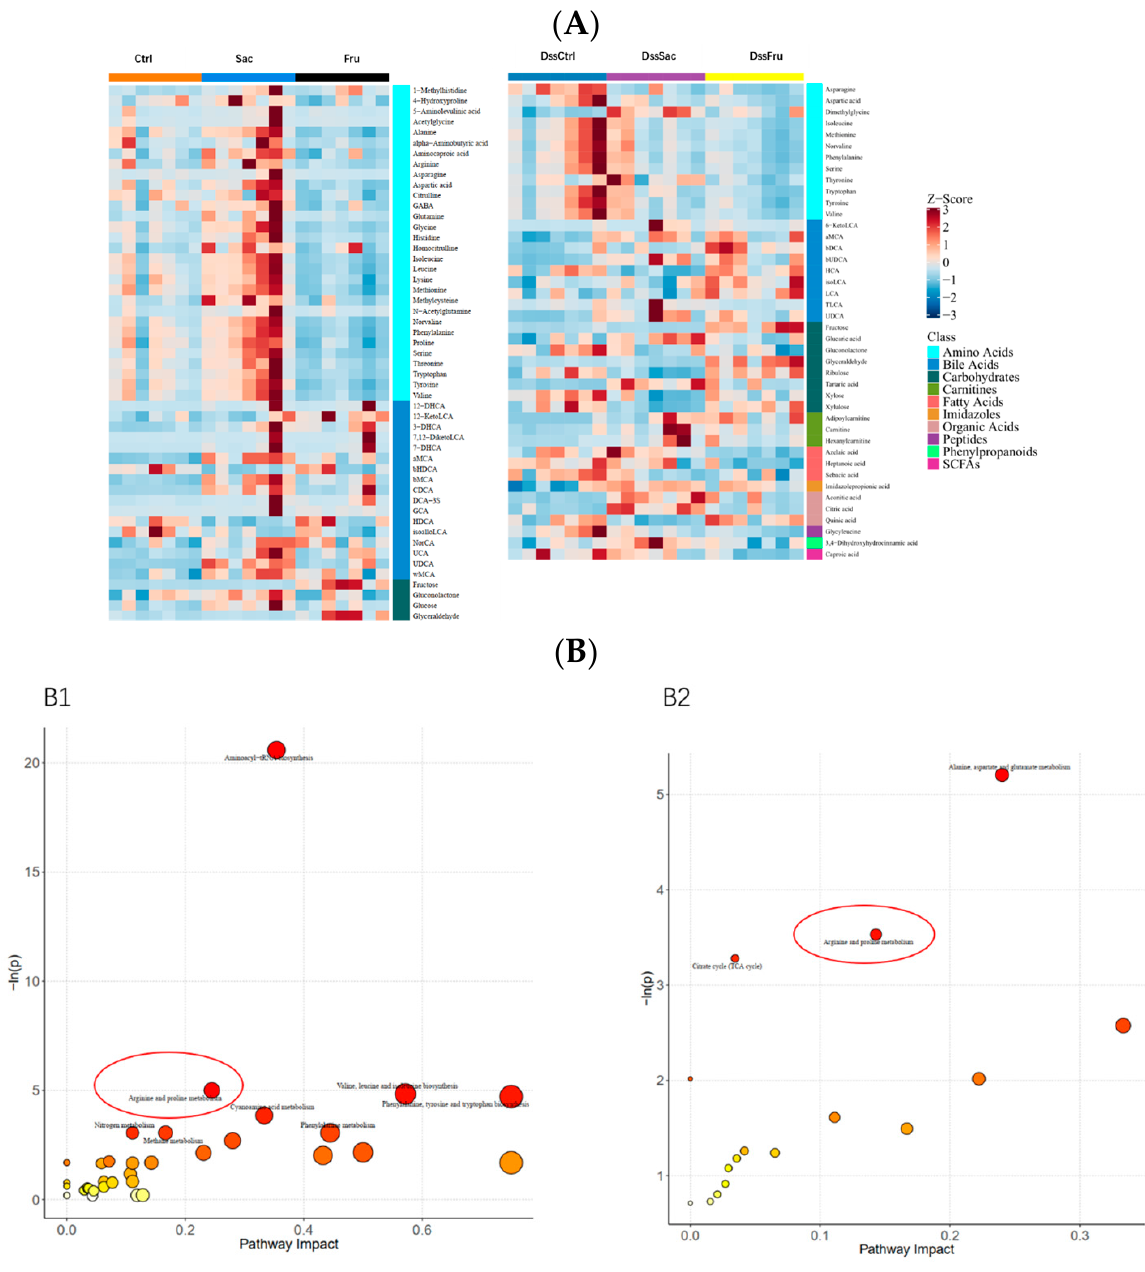
Figure 6. Sucrose and fructose alter colonic metabolite profiles. ( A ) Heatmap of sucrose and fructose’s alteration of metabolites; ( B ) KEGG annotation analysis of the altered metabolites based on the differences between sucrose and fructose; B1 KEGG annotation barplot of Sac vs. Fru; B2 KEGG annotation barplot of DssSac vs. DssFru. The arginine and proline metabolism pathways are highlighted with red circles in the figure.